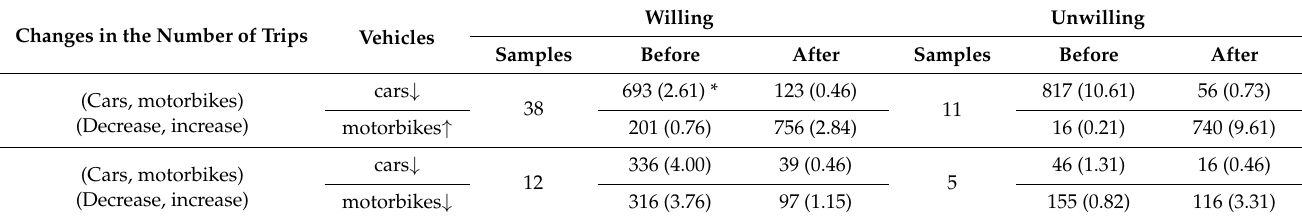
Table 6. Analysis of vehicle changes before and after prohibition, and the willingness and unwillingness of car drivers to use alcohol